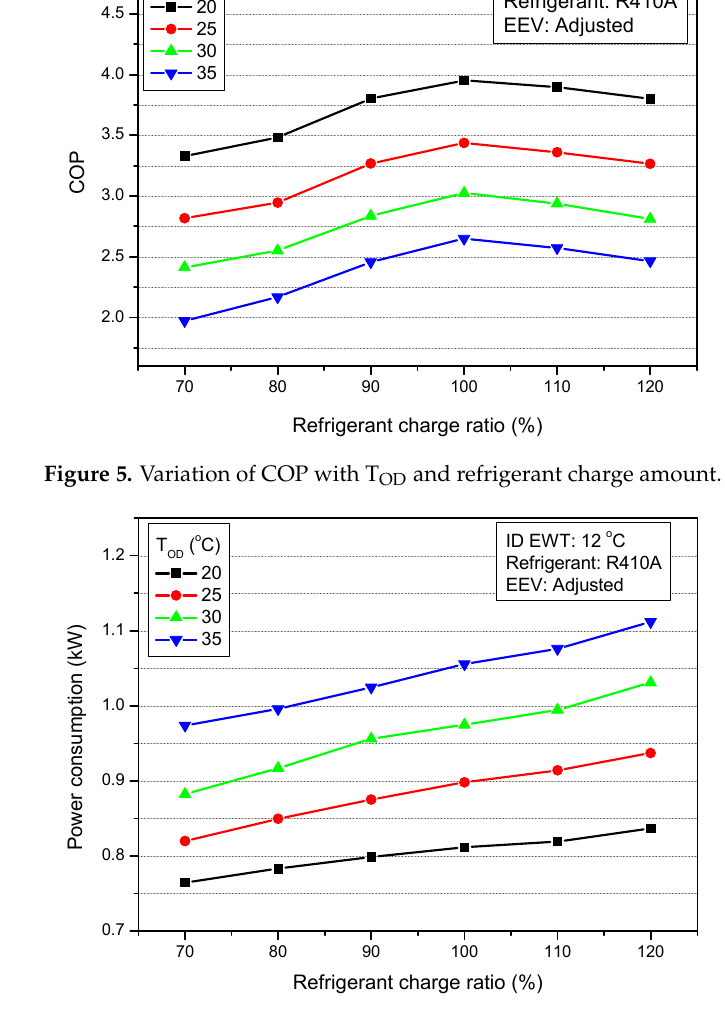
Figure 6. Power consumption with variation of refrigerant charge amount and T (cid:2899)(cid:2888) .